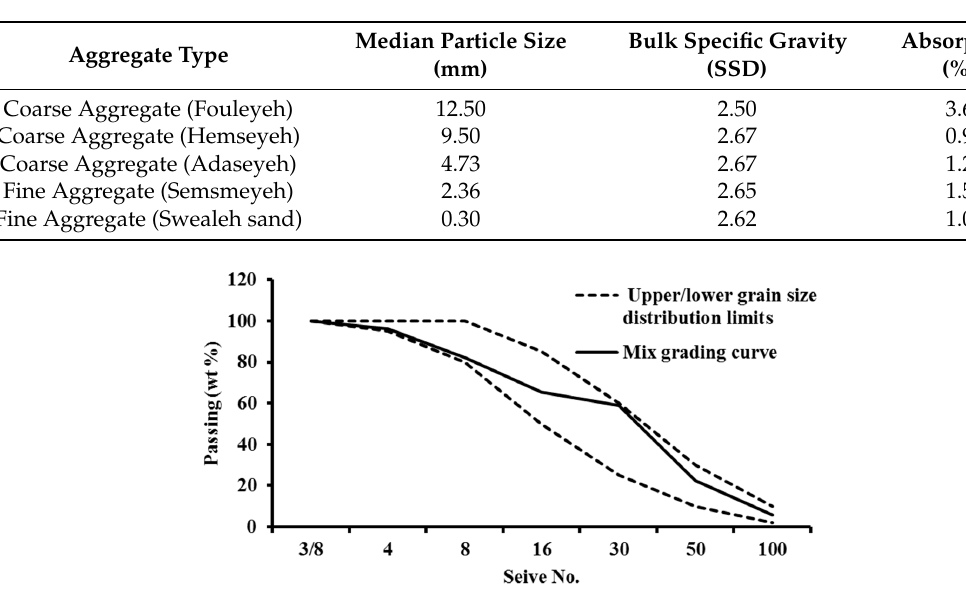
Figure 1. Pattern of grading curve for combined coarse aggregate.